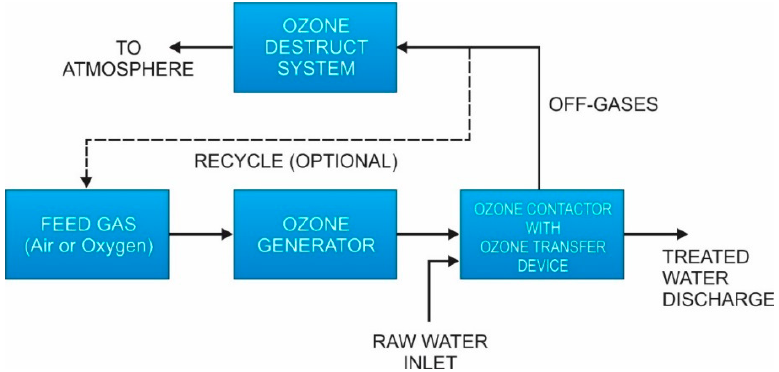
Figure 11. Simplified, conceptual schematic of an ozone generation system. Reprinted with permission of John Wiley & Sons [160].